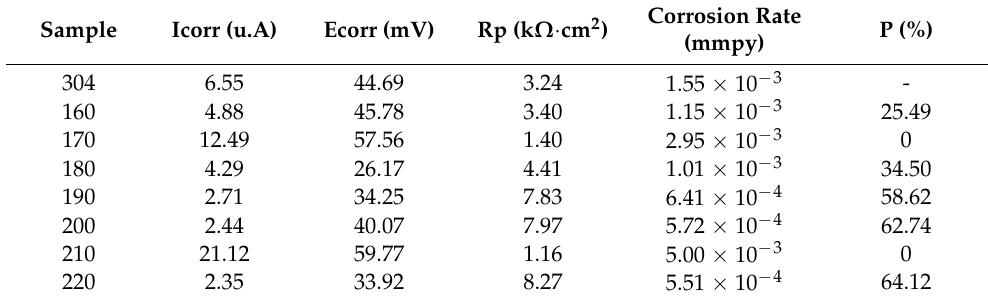
Table 3. Variables obtained from the polarization experiment.